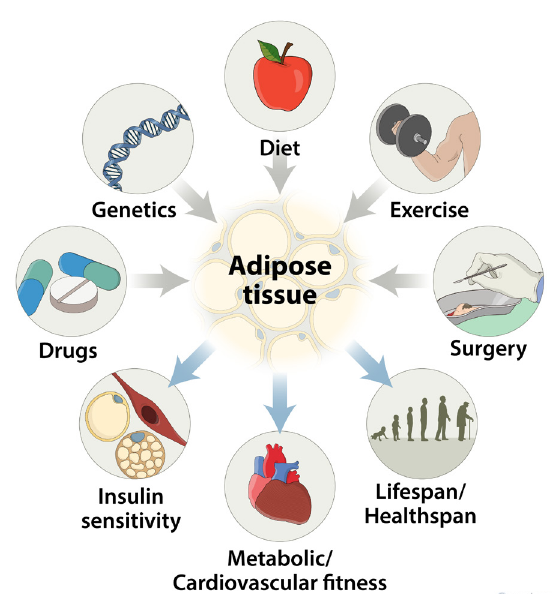
Figure 1. An adipocentric view of aging. The adipose tissue responds to interventions such as diet (e.g., dietary restriction), exercise (e.g., aerobic exercise training), drugs (e.g., thiazolidinediones) and surgeries (e.g., bariatric surgery) and controls whole-body metabolism leading to changes in insulin sensitivity, metabolic/cardiovascular fitness and lifespan/